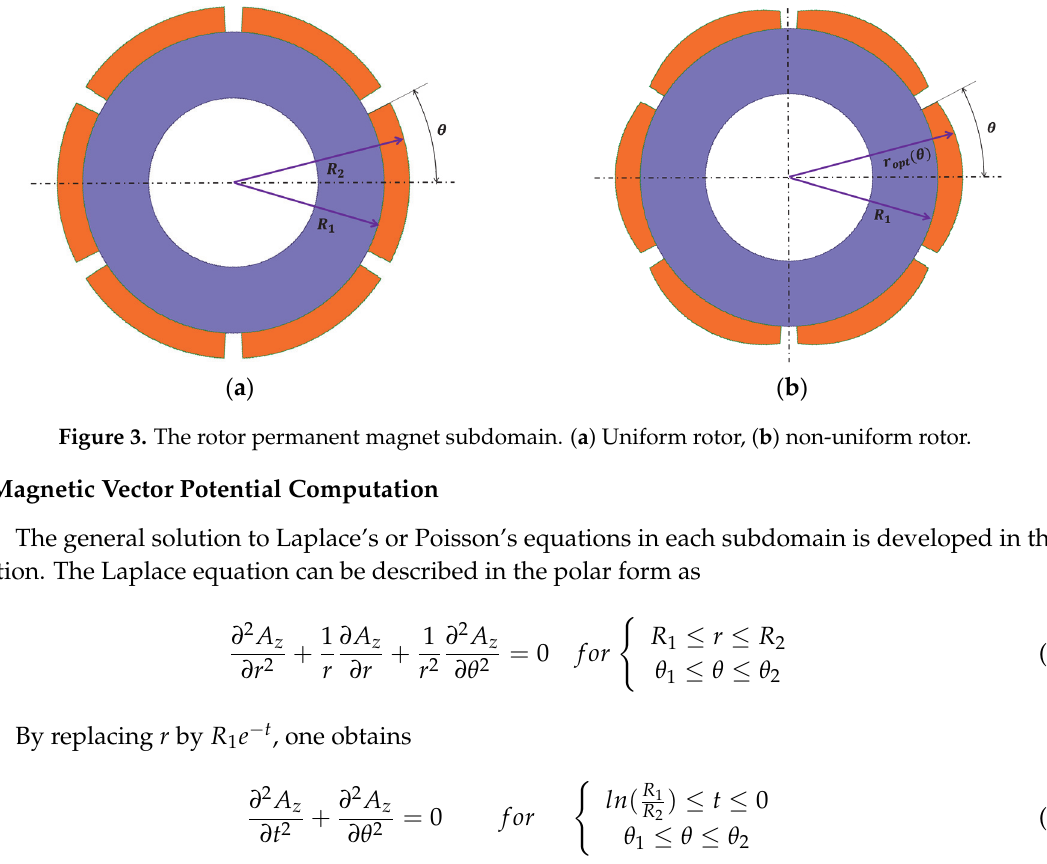
Figure 2. The stator subdomains including the 𝑗 and 𝑖 regions.